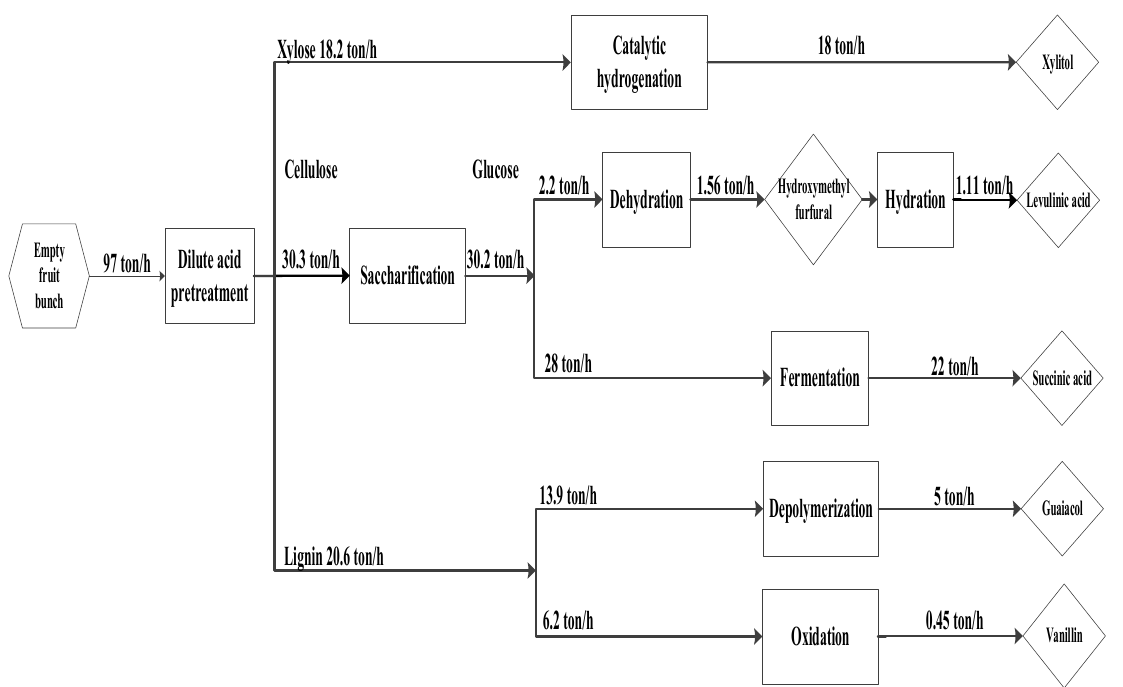
Figure 11. The optimal biorefinery configuration of the optimal point S1 for profit and toxicity damage index in Figure 8b.